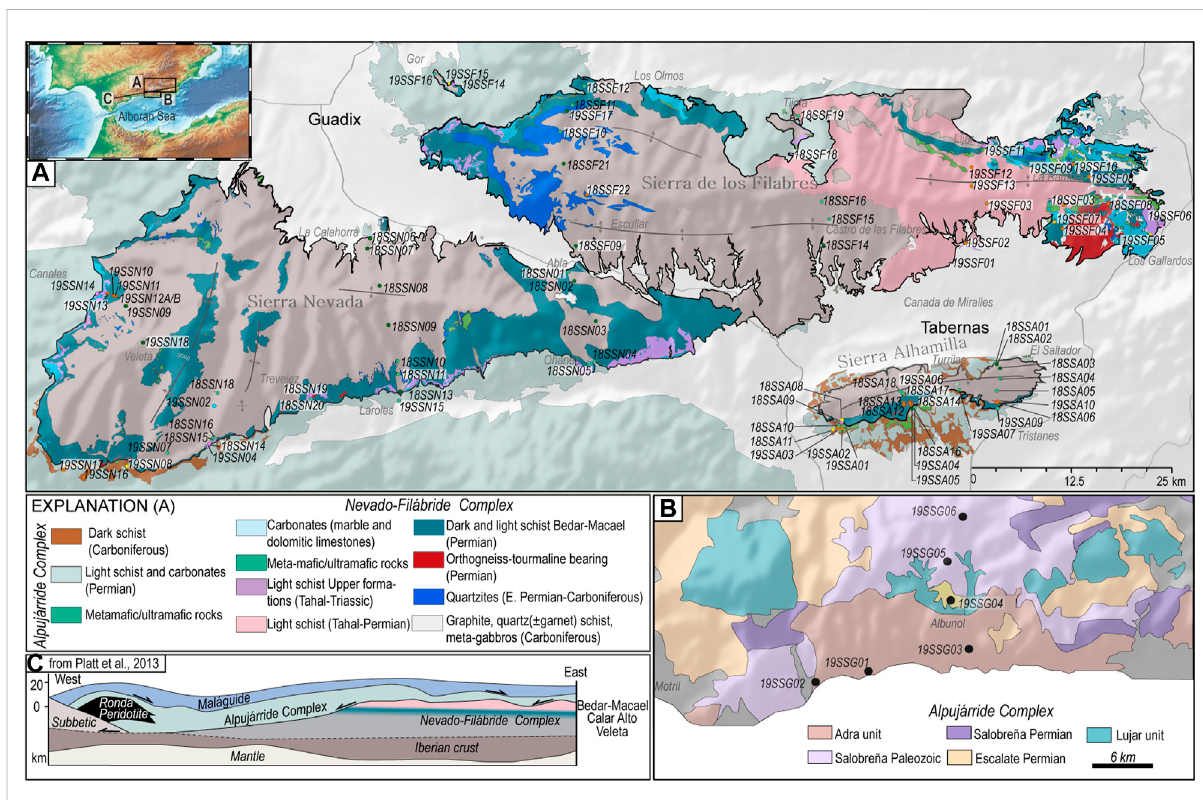
FIGURE 1 (A) Geologic map of southern Spain showing the relationship between mapped units and sample locations. Mapped geologic units modi fi ed after IGME Spain maps (https://info.igme.es). (B) Geologic map from Sierra de la Contraviesa, modi fi ed after Bessière et al. (2021b). (C) Simpli fi ed schematic cross section of the Internal Betics, modi fi ed from Platt et al.